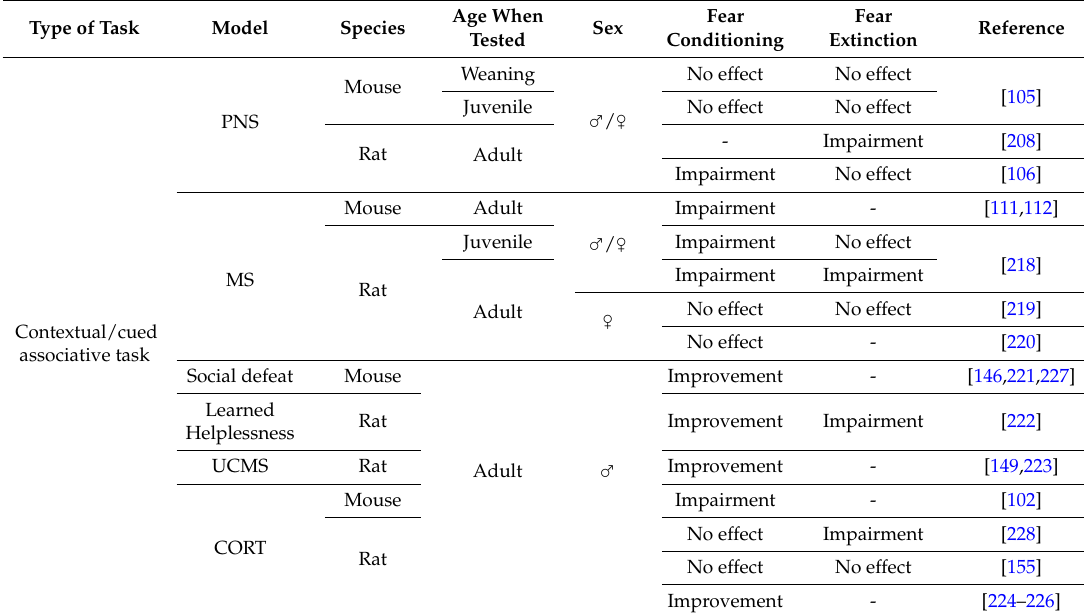
Table 7. Associative memory performances through conditioning tasks in different models of